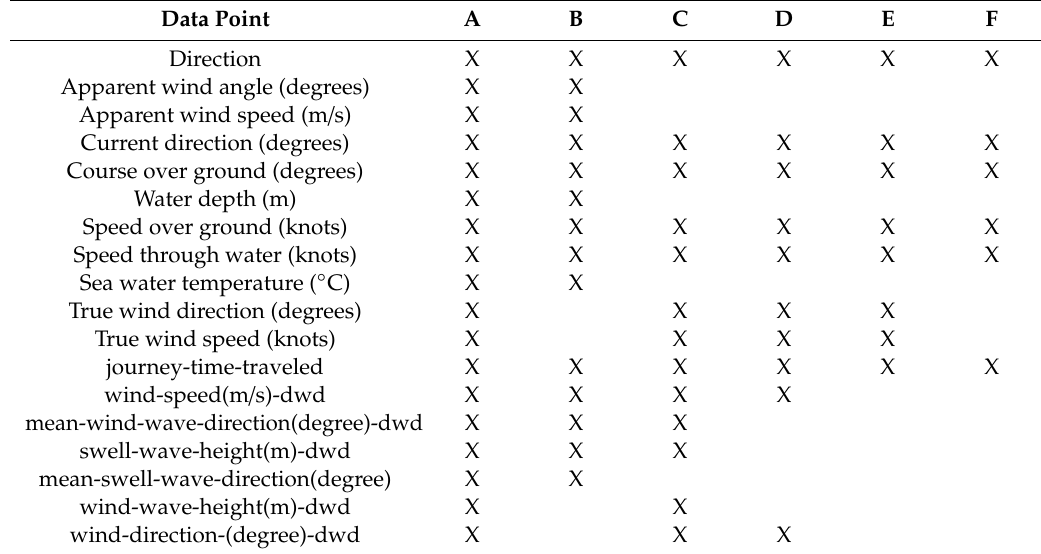
Table 4. Input parameter groups (A to F).